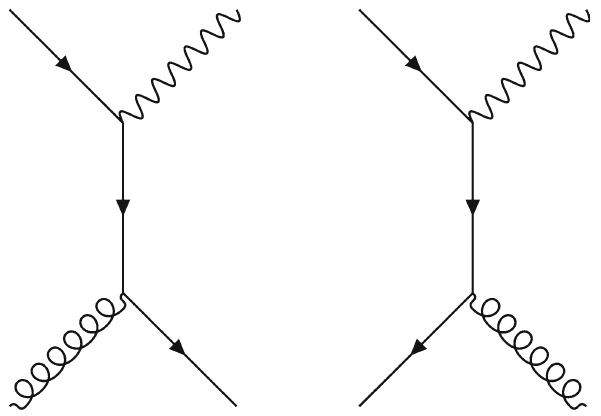
Fig. 1 Feynmandiagramsfordirectphotonproductionatleadingorder via the QCD Compton scattering process (left) and q ¯ q annihilation